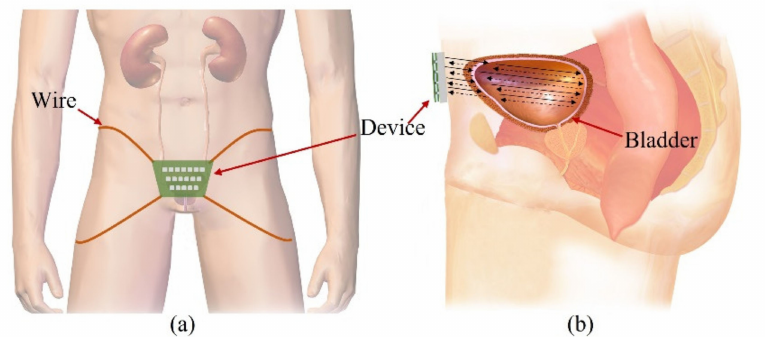
Figure 1. Illustration of the proposed forward-looking wearable urinary bladder scanner system: ( a ) front view and ( b ) side view. This work, “Illustration of the proposed forward-looking wearable urinary bladder scanner system” is licensed under CC BY-SA by Bruce